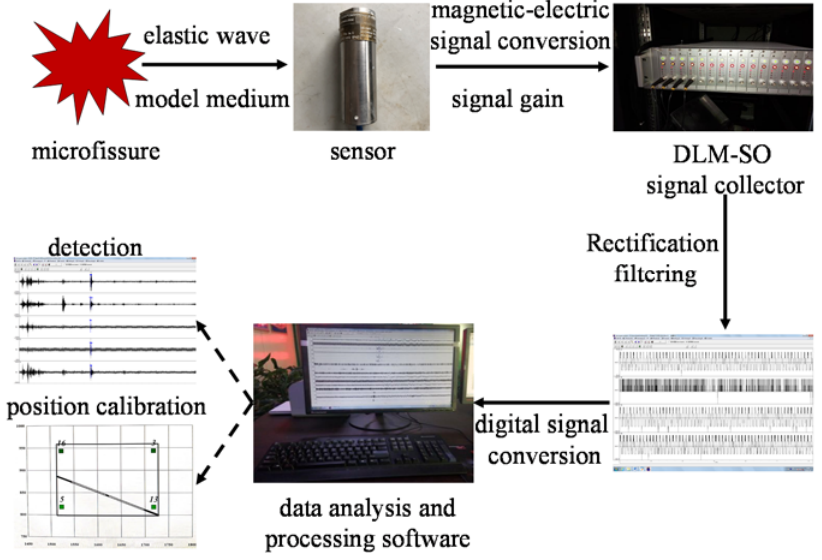
Figure 9. Microseismic (MS) monitoring system.